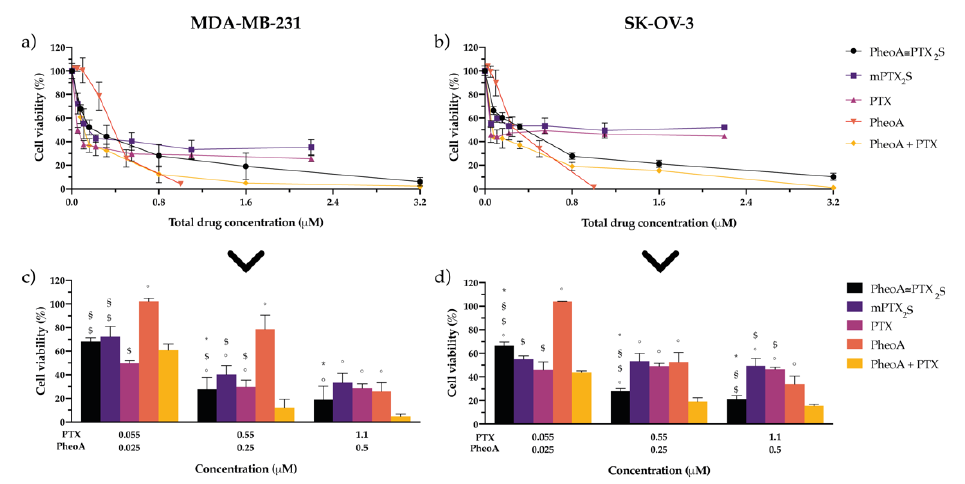
Figure 5. In vitro combination therapy. Dose-response curves of ( a ) MDA-MB-231 or ( b ) SK-OV-3 cells incubated for 24 h with single drugs or their combination delivered free or in nanoparticles and irradiated with 1 J/cm 2 of light; after an additional 24 h in drug-free medium, cell viability was measured by MTS assay. Total drug concentration is referred to PTX + PheoA concentration. Data are expressed as mean percentage ± SD of at least three independent experiments, carried out in triplicate. To better compare the cytotoxic effects of the different drug formulations, some concentrations have been extrapolated: panel ( c ) for MDA-MB-231, and panel ( d ) for SK-OV-3 cells. Statistical significance was calculated applying the ANOVA Two-way with Bonferroni’s correction: * significantly different from mPTX 2 S; § significantly different from PTX; $ significantly different from PheoA; ◦ significantly different from PheoA + PTX. Table 1. IC 50 and Dose-Reduction Index (DRI) values calculated by the Compusyn analysis of cytotoxicity data (Figure 5a,b) of MDA-MB-231 and SK-OV-3 cells exposed to the different drug formulations/combinations. The DRI values were calculated for cells exposed to combination therapy and indicate how many folds the concentration of each single drug can be reduced to obtain a survival value (Fa, Fraction affected) of